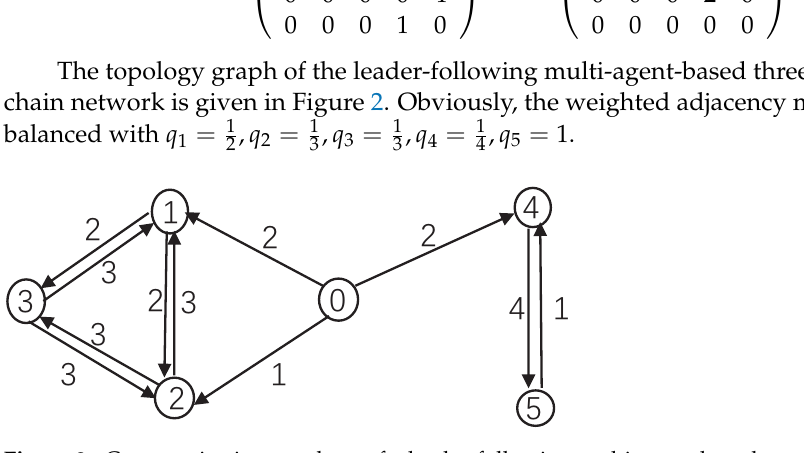
Figure 2. Communication topology of a leader-following multi-agent-based supply chain